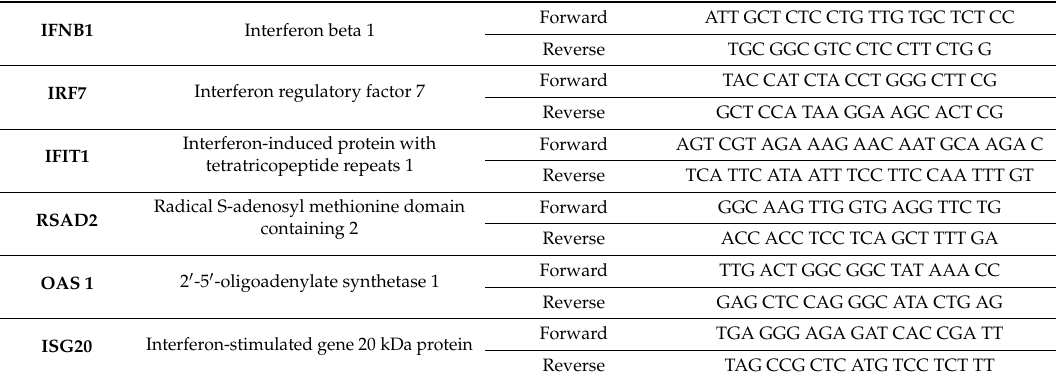
Table 1. Sequences of the primers used for transcriptomic analysis of the innate anti-viral immune response in